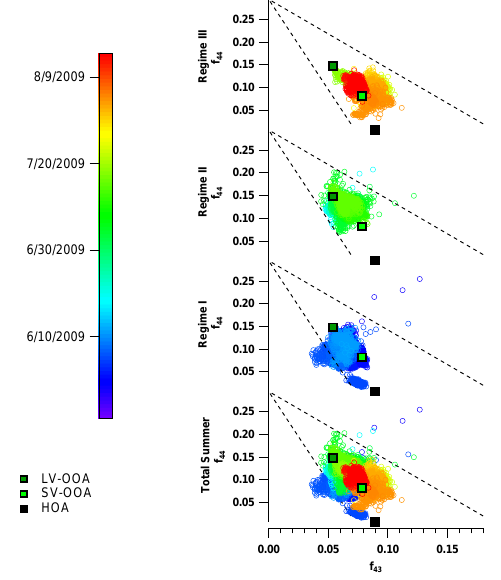
Fig. 8. f 44 vs. f 43 for PACO, with color scale corresponding to date. Square markers represent values for HOA, SV-OOA, and LV-OOA factors identified in PACO.